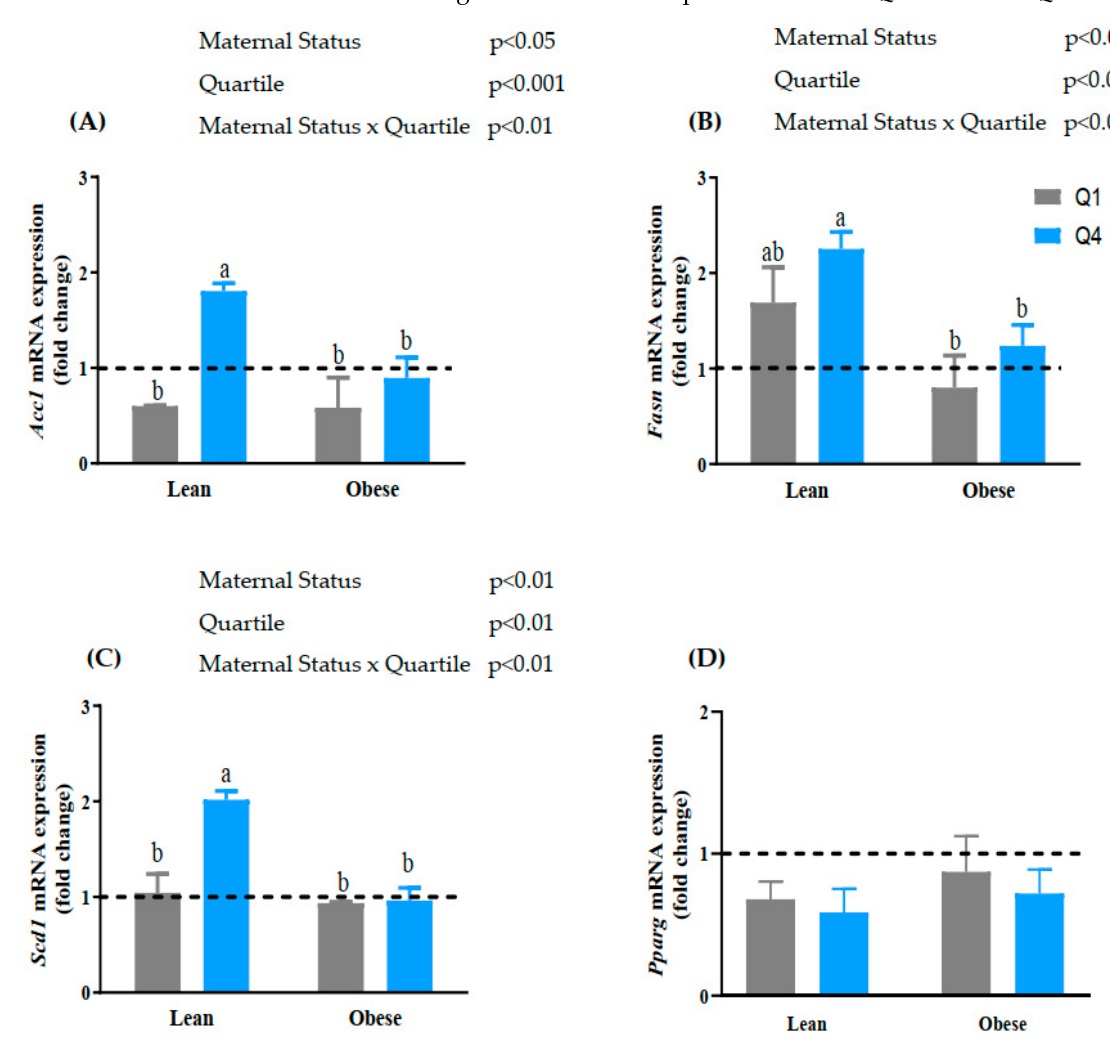
Figure 2. Effects of non-obese and obese breast milk with high and low n-6:n-3 PUFA ratios on the mRNA expression of lipogenic and adipogenic genes in 3T3-L1 adipocytes. Preadipocytes were differentiated for 8 days in the presence or absence of breast milk (BM) whey. Data represent the mRNA expression of: ( A ) acetyl CoA carboxylase ( Acc1 ), ( B ) fatty acid synthase ( Fasn ), ( C ) stearoyl- CoA desaturase-1 ( Scd1) , and ( D ) peroxisome proliferator-activated receptor gamma ( Pparg ). The mRNA expression was normalized with RPLP0 as the reference gene. Values for the control cells (no breastmilk treatment) were set to 1.0 and are represented by the dashed line. Values are ex- pressed as mean ± SD, n = 3. Data were analyzed using two-way ANOVA to determine the effect of treatment, and a Bonferroni post hoc test was used to determine differences when there was a sig- nificant interaction. Different superscript (a, b) represent significant differences between treatment groups, p < 0.05 was considered significant. Q—quartile. 3.5. Maternal BMI and BM n-6:n-3 PUFA Ratio Had No Significant Effect on the mRNA Expression of Lipolytic Genes